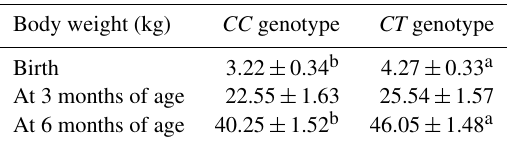
Table A5. Least-squares analysis of body weight parameters of three-way crossbred lambs with different genotypes (least-squares mean ± standard error).